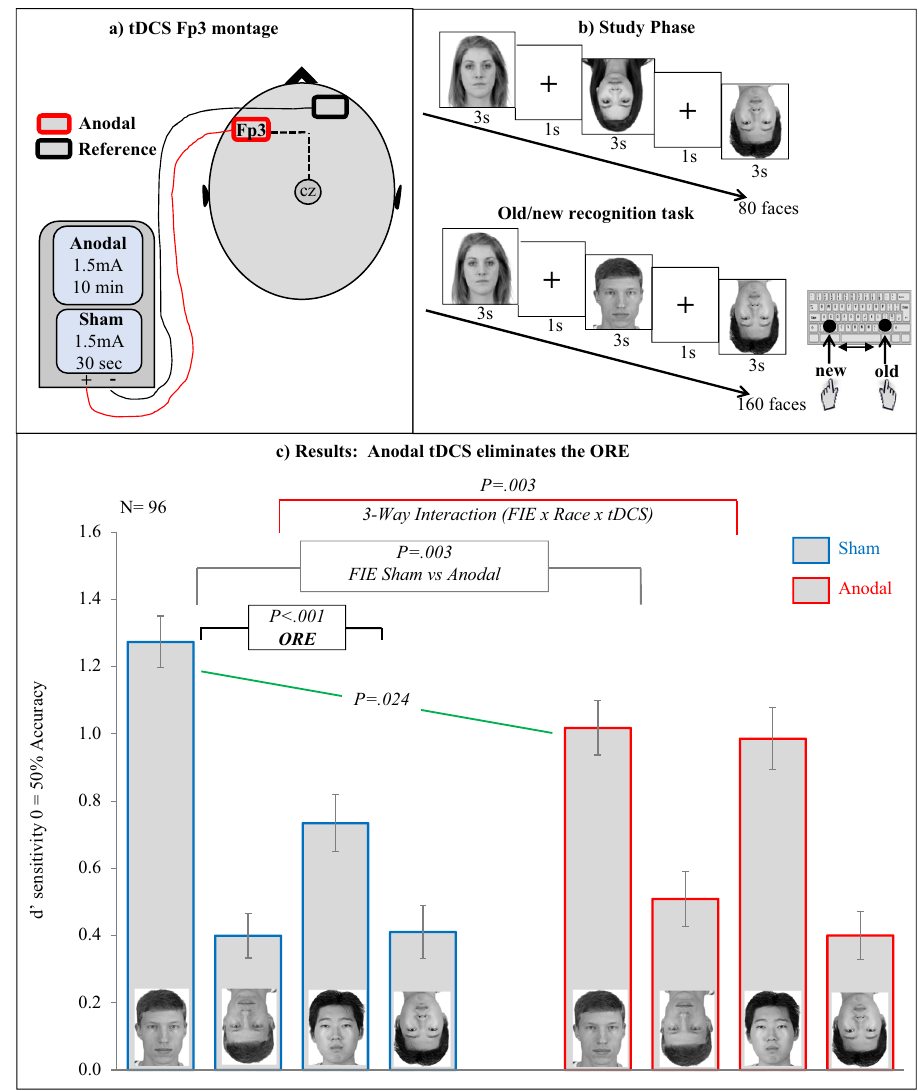
Figure 1. ( a ) The tDCS montage adopted in the study. ( b ) The old/new recognition task used. ( c ) The results from the study. The x -axis shows the face types in each tDCS group. The y -axis shows sensitivity d ′ measure. Error bars represent s.e.m. The face images were selected from the open access Chicago Face Database (www. chica gofac es. org) 55–60 . Publishing permission of these images was granted from the Center for Decision